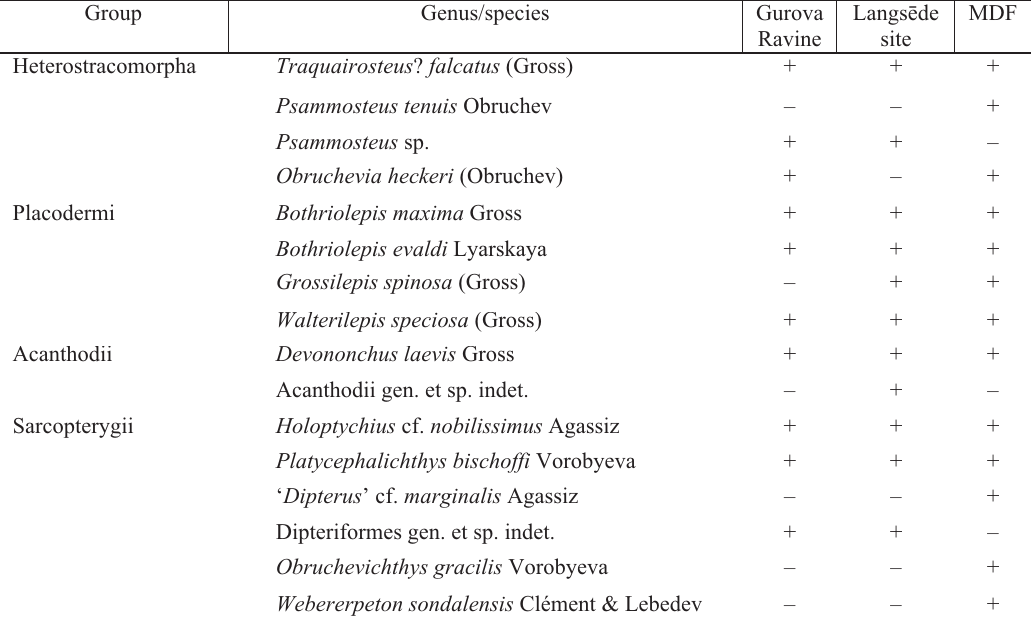
Table 2. List of vertebrate taxa identified in the Gurova Ravine, at the Langsēde site (Lukševičs et al. 2011) and in the Pamūšis Regional Stage of the Main Devonian Field (MDF; after Esin et al. 2000) /1'0<